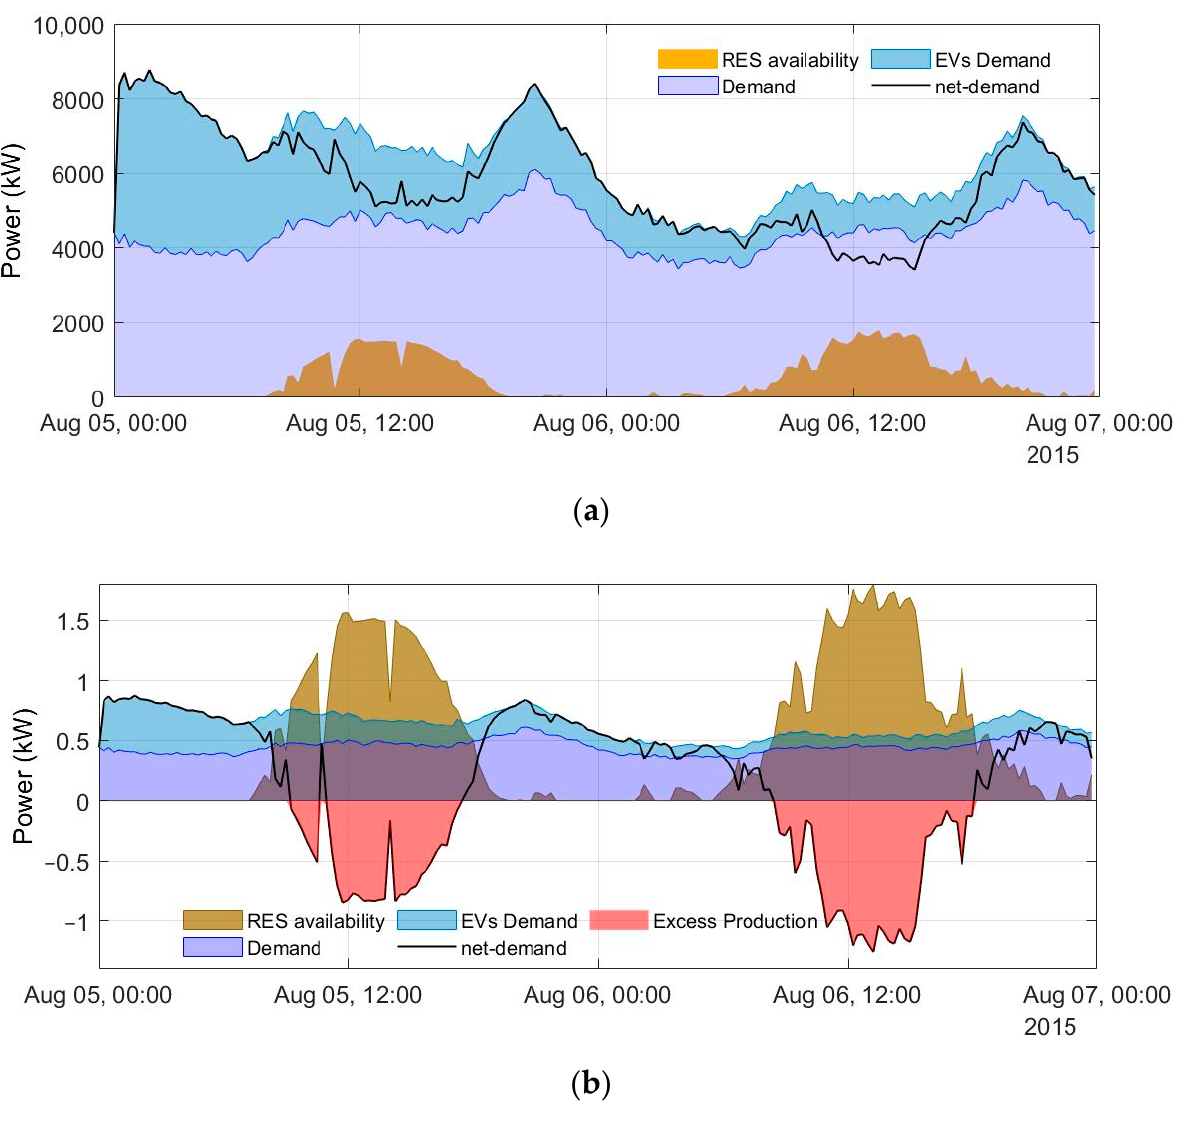
Figure 5. RES availability and electricity, demand, and the net-demand of the island for two consecutive days. ( a ) presents the island’s current situation; ( b ) illustrates a high RES (solar and wind) penetration for the same period.